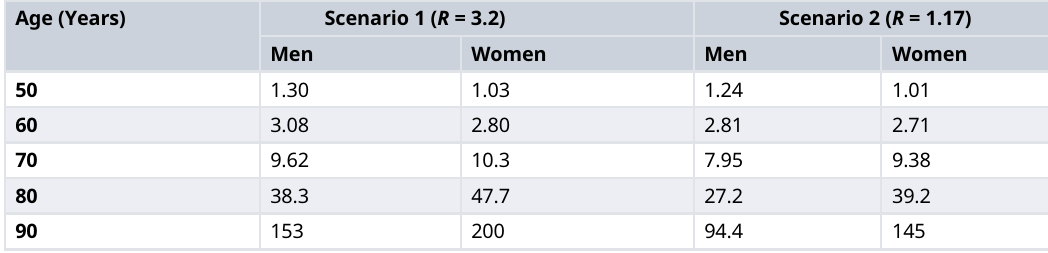
Table 1. Incidence rate per 1000 PY in two scenarios for 2015 by sex, age and mortality rate ratios ( R ) separately. Scenario 1: R = 3.2, scenario 2: R = 1.17 for all ages. Age (Years) Scenario 1 ( R = 3.2) Scenario 2 ( R = 1.17)